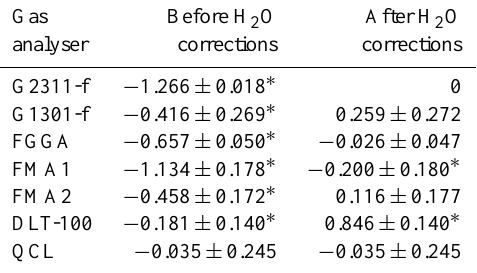
= Table 4. Summary of the values for slope k of a linear fit 1F CH 4 kF WPL , where 1F CH is the difference between fully corrected CH 4 4 G2311-f CH 4 flux and flux from the gas analyser in question, and F WPL is the correction term related to density corrections (second CH 4 term on the right-hand side in Eq. (5)). F WPL was calculated using CH 4 H 2 O measured with LI-7000 and the lag time of H 2 O itself, mean- ing that the used H 2 O covariance was maximised for every averag- ing period. Values and standard errors for slope k are given before and after H 2 O corrections (density and spectroscopic correction).